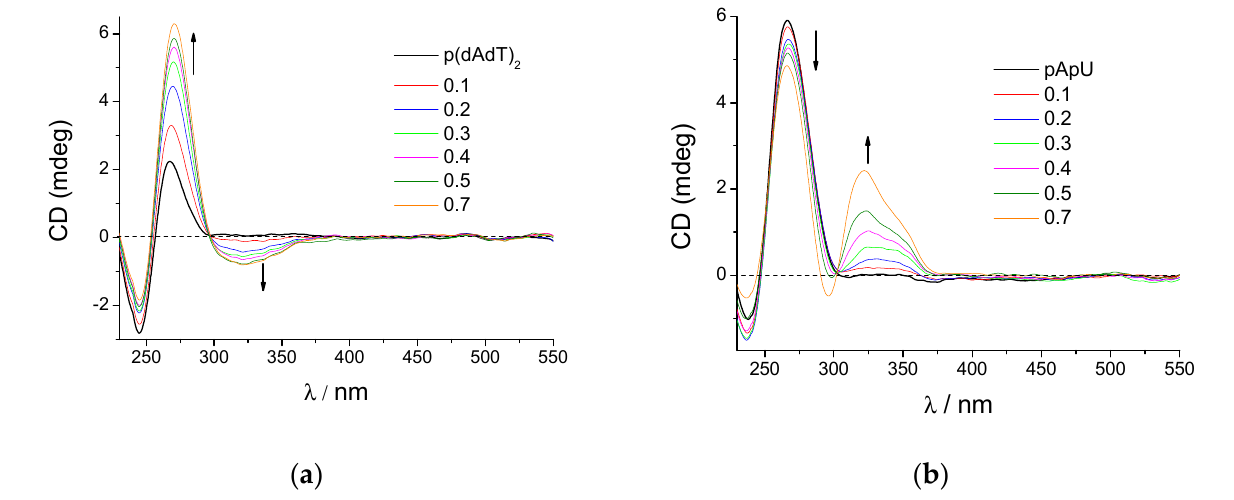
Figure 4. CD titration of ( a ) poly dAdT-poly dAdT, ( b ) pApU (c = 2 × 10 − 5 M) with 1M at molar ratios r = [compound]/[polynucleotide] (pH 7.0, sodium cacodylate buffer, I = 0.05 M).